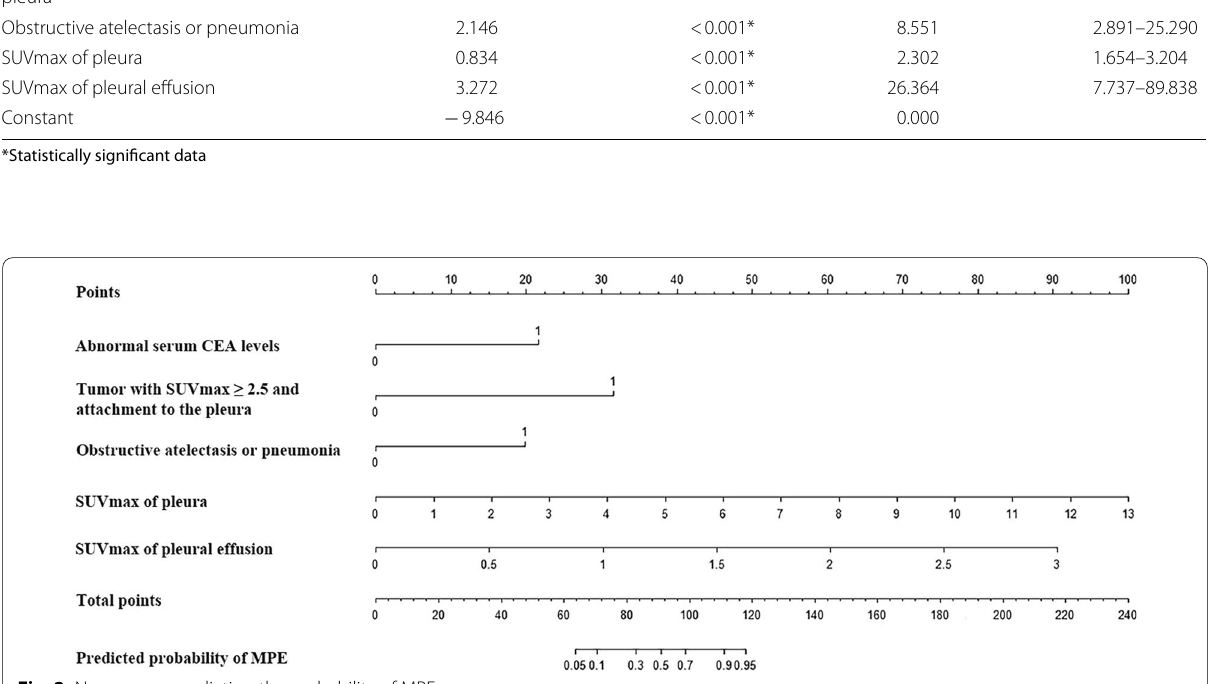
Fig. 2 Nomogram predicting the probability of